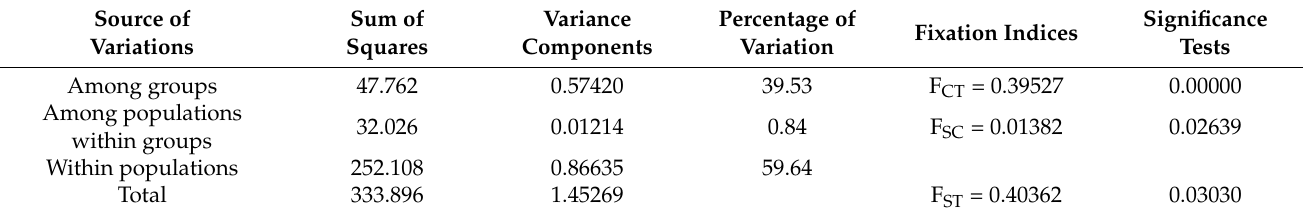
Table 3. AMOVA analysis of the G. japonicus